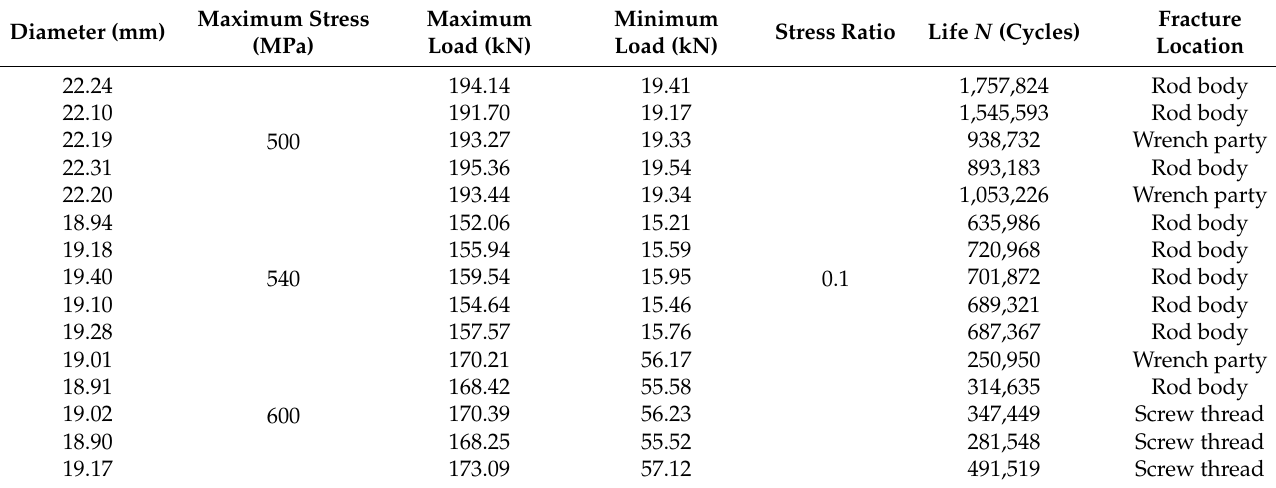
Table 2. Fatigue test results of HY-type sucker rods.